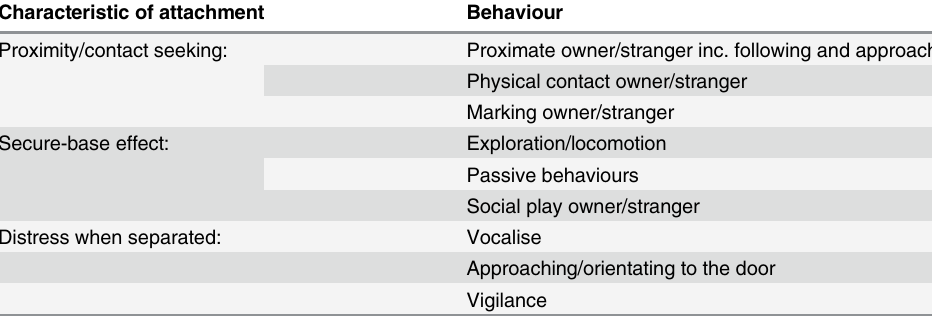
Table 2. List of behaviours statistically analysed and the corresponding characteristic of attachment they may indicate. See S1 File for definition of the specific behaviours as used for their identification from the